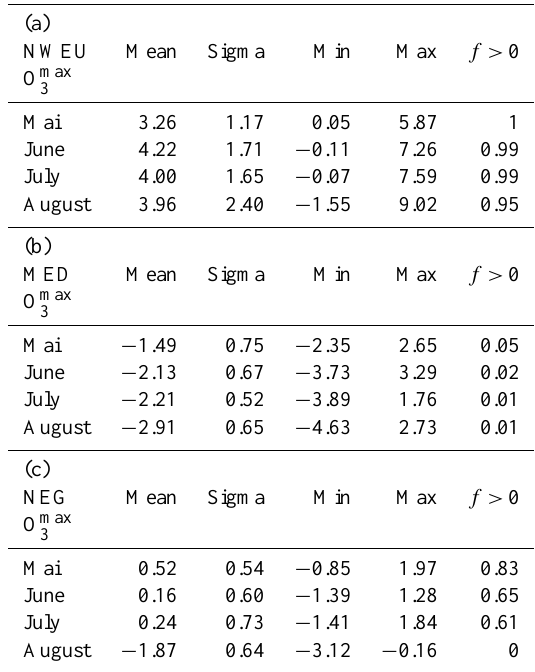
Table 3. Statistical measures for the average chemical regime for O max statistics as in Table 1, but stratified as a function of 3 the month, for the period 2001–2003; (a) North-Western Europe, NWEU, (b) Mediterranean, MED, and (c) North-Eastern Germany, NEG.